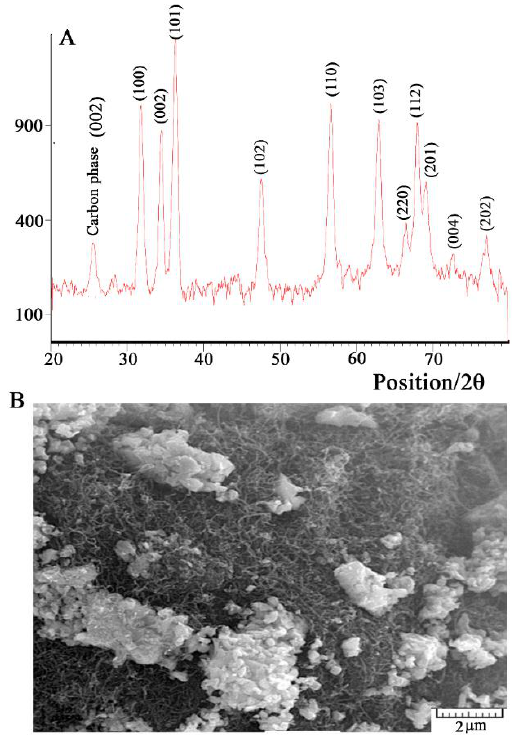
Figure 1. ( A ) XRD pattern of ZnO/CNTs nanocomposite. ( B ) SEM images of ZnO/CNTs nanocomposite .